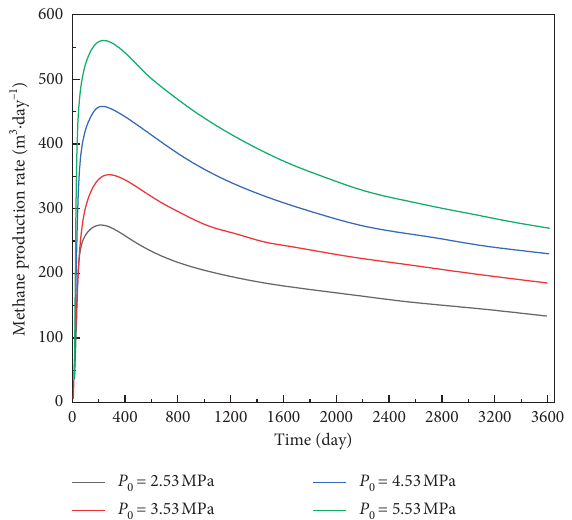
Figure 6: Variation of methane production rate with different initial coalbed pressure.